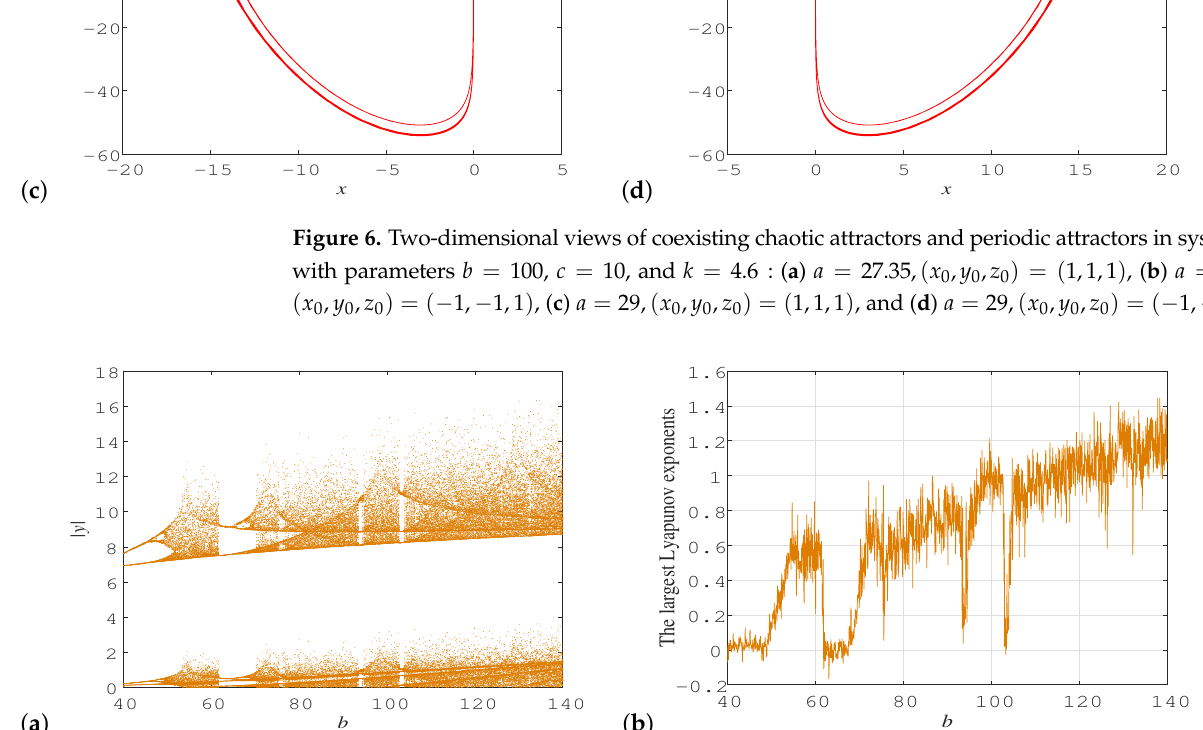
Figure 7. ( a ) Bifurcation diagram of | y | with b as the varied parameter and ( b ) the largest Lyapunov exponent spectrum, where a = 12, c = 10, and k =